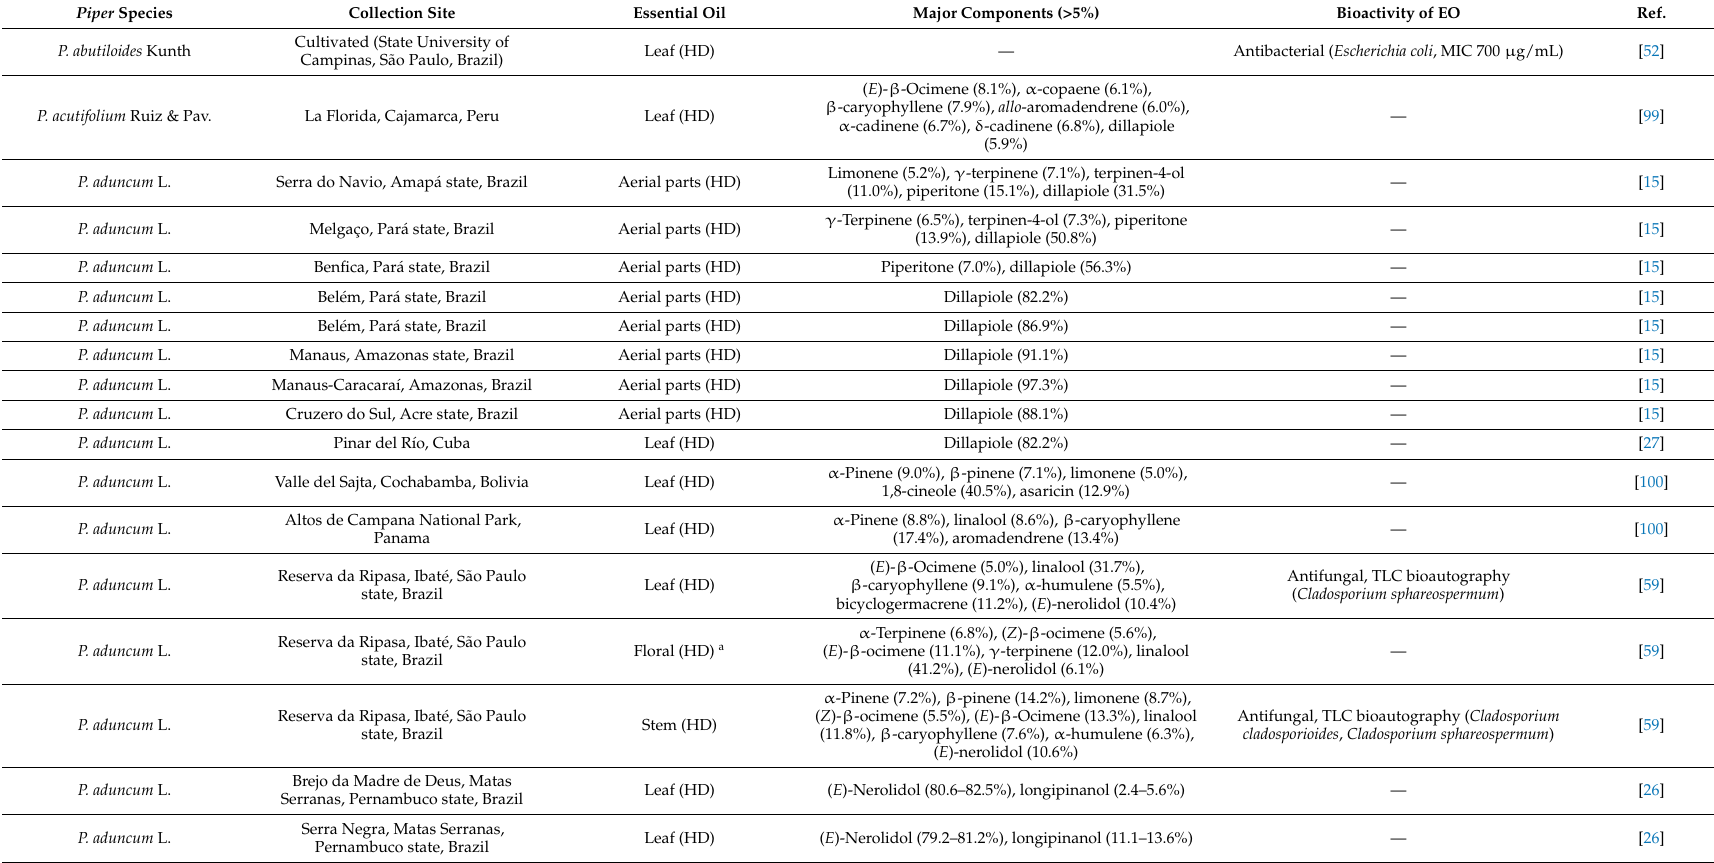
Table A1. Neotropical Piper essential oil compositions and biological